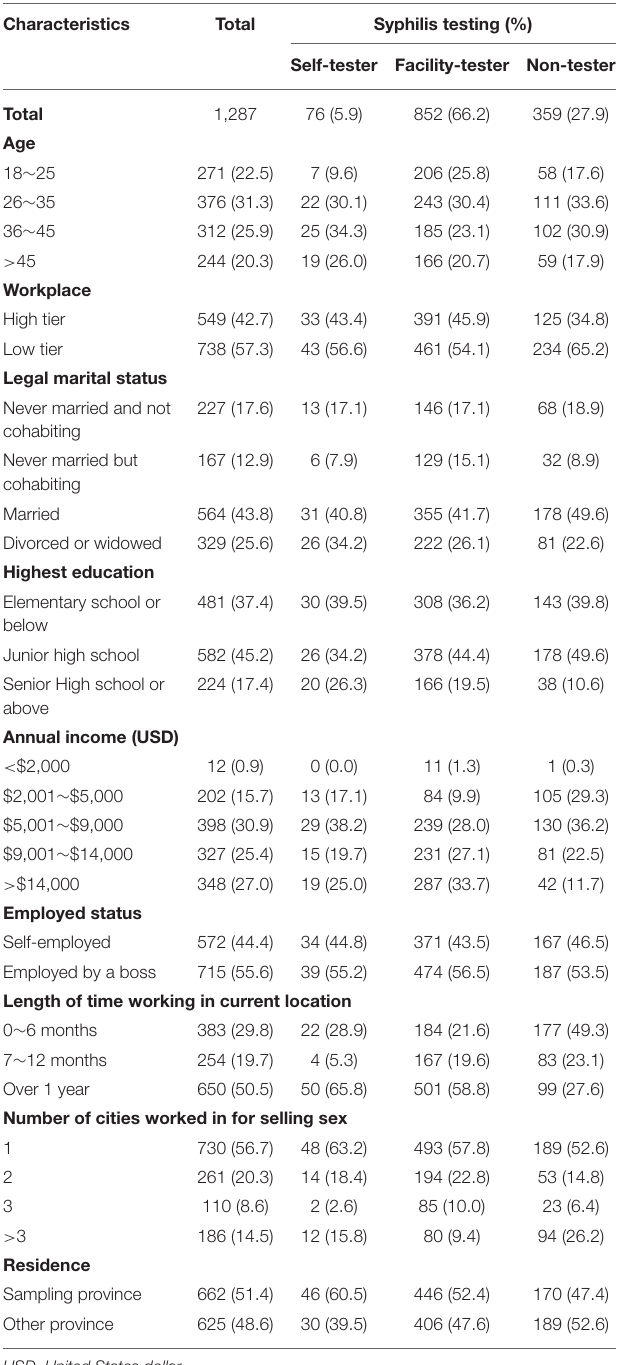
TABLE 1 | Social demographic characteristics among female sex workers, a cross-sectional survey in China, 2019.